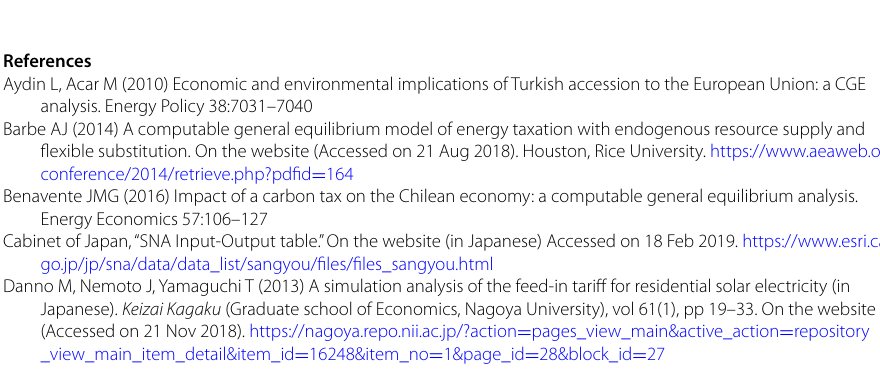
results show that the power switch from thermal power to renewable energy becomes smaller and substitution of nuclear and hydro for thermal power generation are slightly bigger than the original results. These results are attributed to the enhanced elasticity of substitution between the power sources.